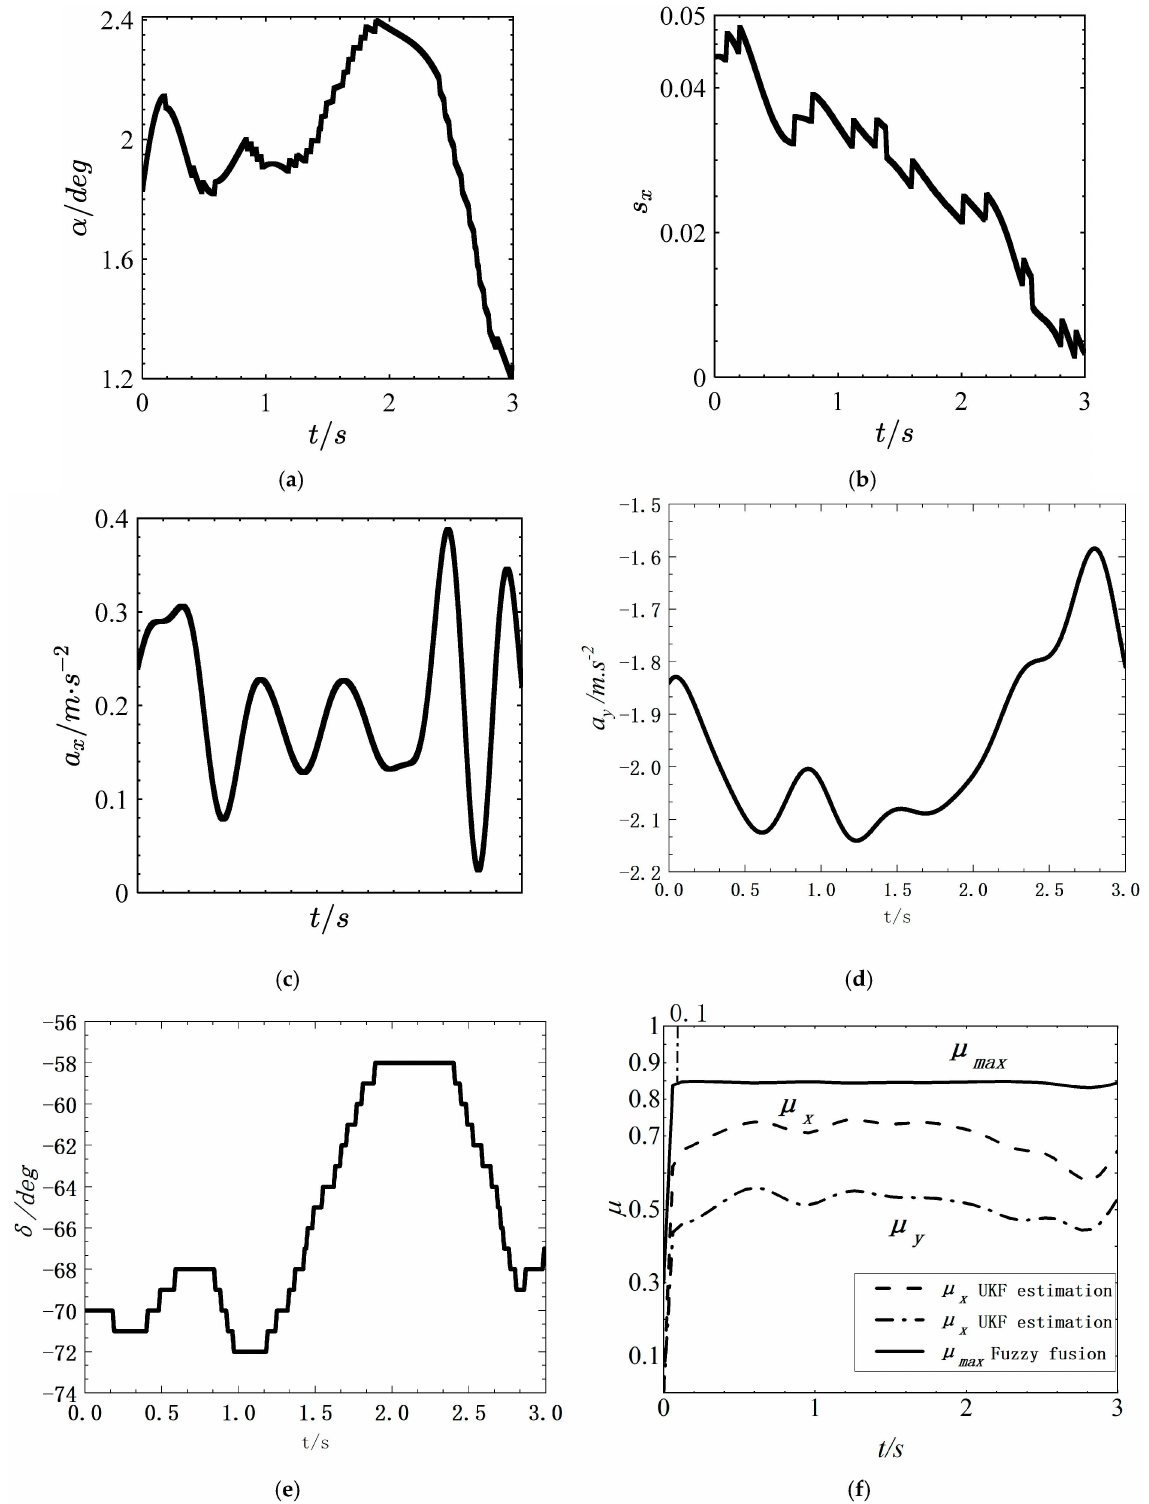
Figure 16. Simulation results under combined bending braking conditions. ( a ) Lateral deflection angle. ( b ) Longitudinal slip rate. ( c ) Longitudinal acceleration. ( d ) Lateral acceleration. ( e ) Steering wheel cornering. ( f ) Estimated pavement adhesion